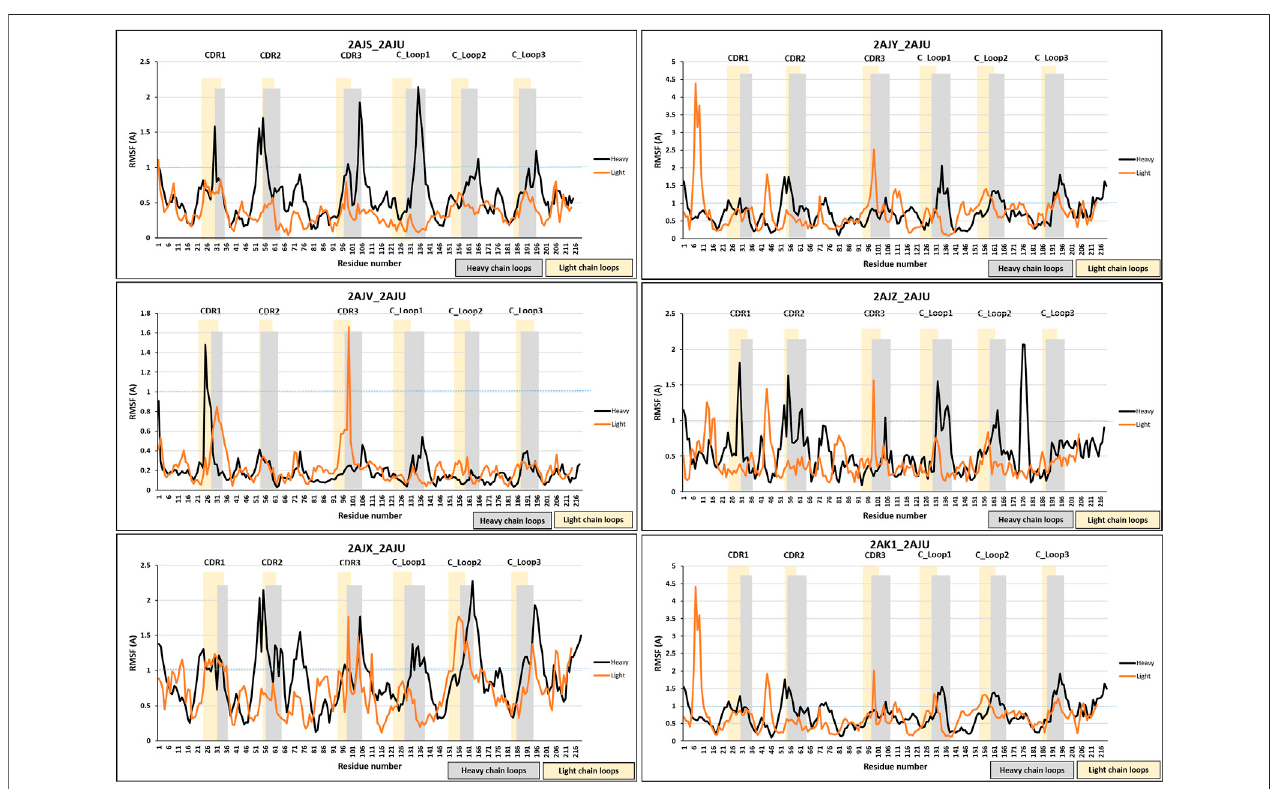
FIGURE 5 | RMSF analysis of antibody 7A1. RMSF measurements were analyzed for the six bound states of antibody 7A1. Blue dotted line was placed at RMSF 1 Å to allow easier comparison. The bound states were 2AJS, 2AJY, 2AJV, D 2AJZ, 2AJX, and